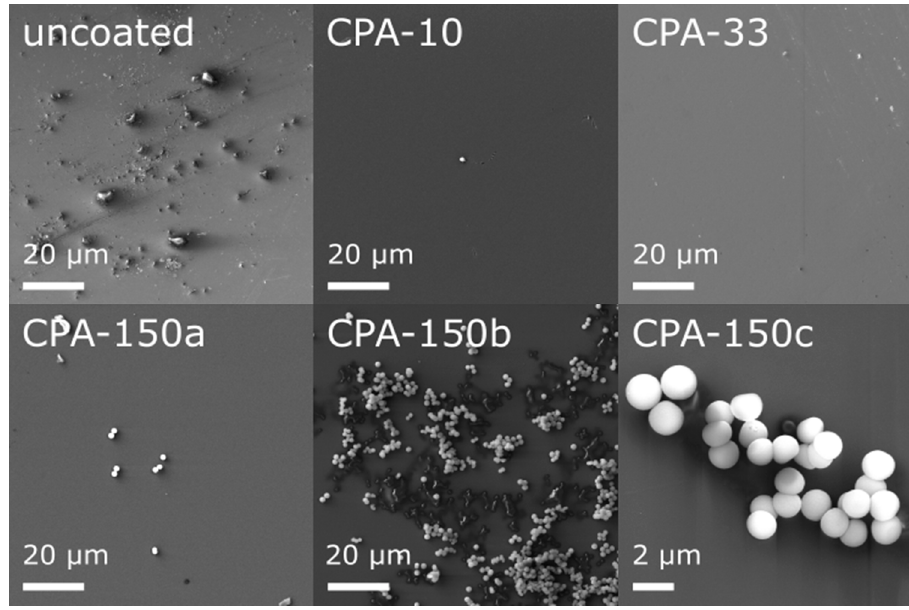
Figure 1. Micrographs of the surface of uncoated and plasma polymer (PP)-coated polystyrene (PS) culture dishes after 7-day exposure to the culture medium (without cells). CPA-10, CPA-33, CPA-150: PPs were deposited at the average RF power ( P av ) of 10, 33, and 150 W, respectively. CPA-150a, CPA-150b, CPA-150c show different regions with different magnifications on the CPA-150 sample.